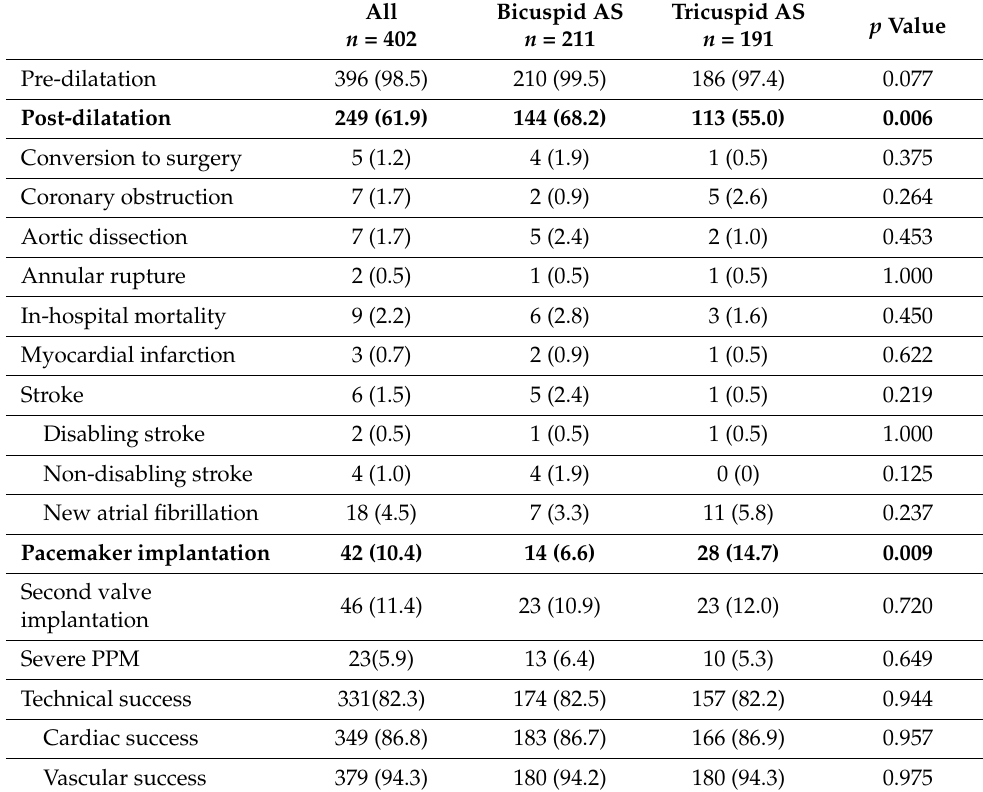
Table 2. Procedural characteristics and in-hospital outcomes.